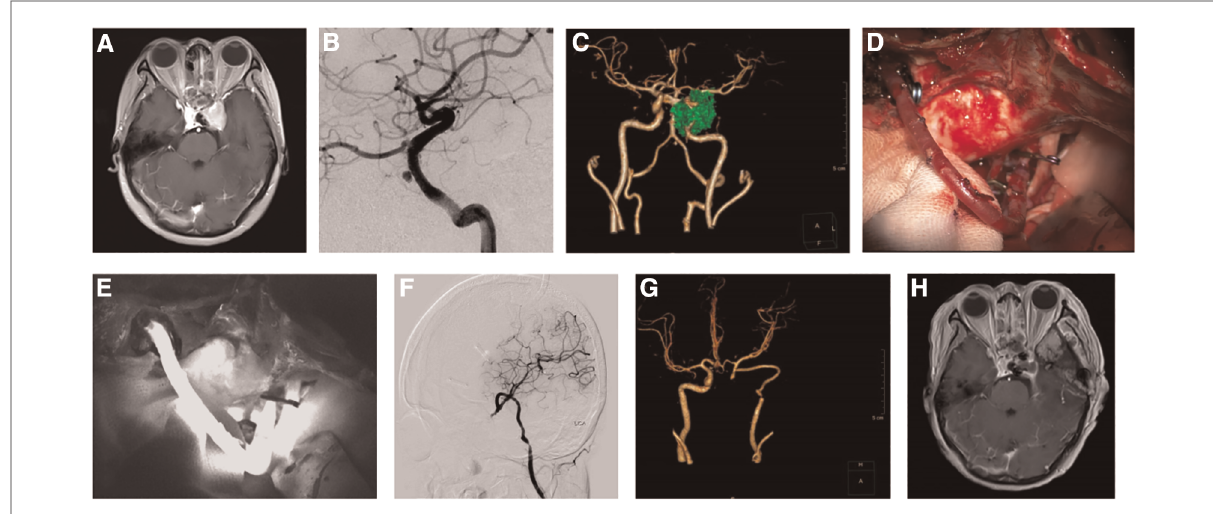
FIGURE 1 Images of a patient before and after Fukushima bypass type I. ( A ) Enhanced magnetic resonance imaging (MRI) showing a pituitary adenoma in the sellar region involving the cavernous sinus and encasing the left internal carotid artery. ( B ) Digital subtraction angiography (DSA) showed pseudoaneurysm of the internal carotid artery. ( C ) Computed tomography angiogram (CTA) showing tumor encasing the left internal carotid artery and aneurysm. (D ). Intraoperative image of Fukushima bypass. ( E ) Intraoperative fl uorescein angiography showing patent bypass blood fl ow. ( F ) Postoperative reexamination of MRI showing subtotal resection of the tumor. ( G ) Postoperative CTA showing patent blood fl ow in radial artery graft. ( H ) Postoperative DSA showing patent blood fl ow after vascular